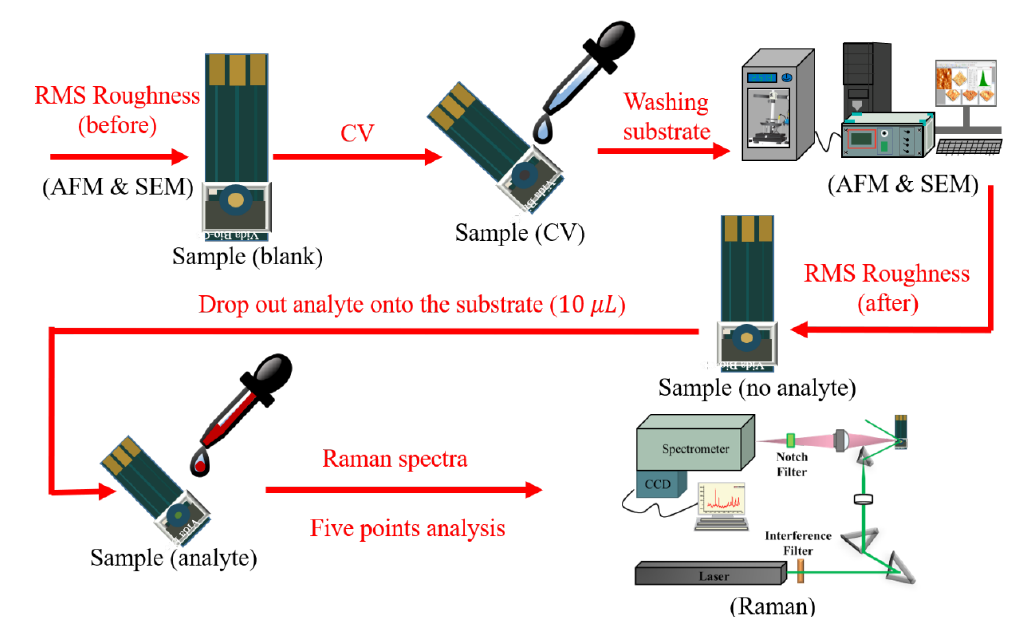
Figure 2. The flowchart of experimental procedure. AFM: atomic force microscope; SFM: scanning electron microscope; CV: cyclic voltammetry; SERS: surface-enhanced Raman scattering.